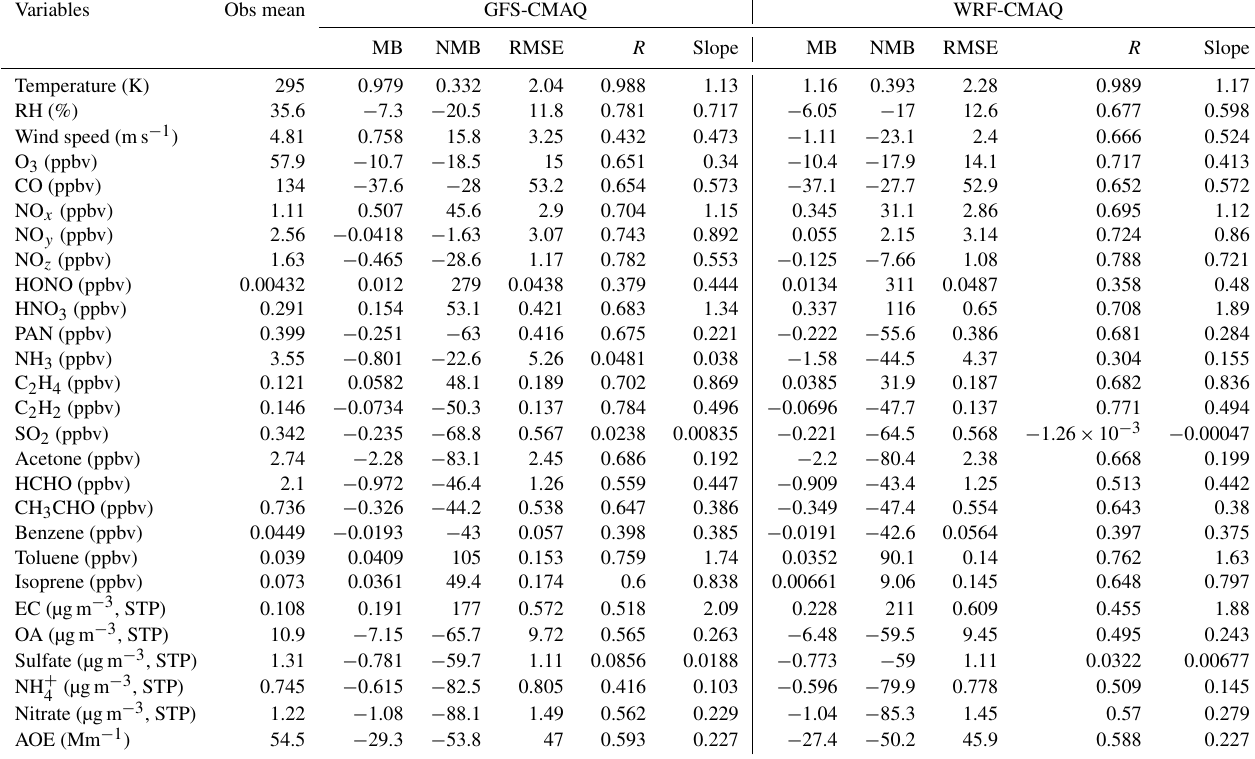
Table 2. Statistics of the two models compared to the observations for DC-8 flight segments without fire influences below 3kma.s.l. over the region west of − 100 ◦ W. All aerosols have a diameter of less than 1µm. The normalized mean bias (NMB) is given as a percentage.